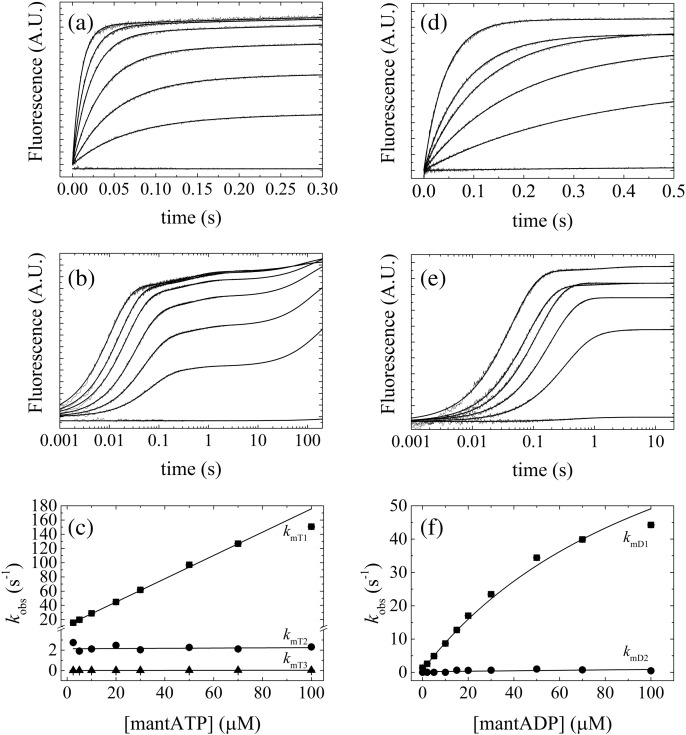
Mant-Nucleotide binding to Dbp5. (a) Time courses of fluorescence change after mixing 0.5 μM Dbp5 with (lower to upper) 0, 2.5, 5, 10, 20, 30, or 50 μM mantATP. The smooth lines through the data represent the best fits to three exponentials. (b) Full time courses from (a) shown on a log scale to 200 s. (c) [mantATP] dependence of the observed rate constants associated with mantATP binding. Continuous lines represent the best linear fits to the data. Uncertainty bars representing the standard errors of the best fits are within the data points. (d–f) Analogous mantADP binding data fitted to two exponentials shown on linear (d) and log (e) scales and with rate constants fitted to hyperbolic or linear functions (f).